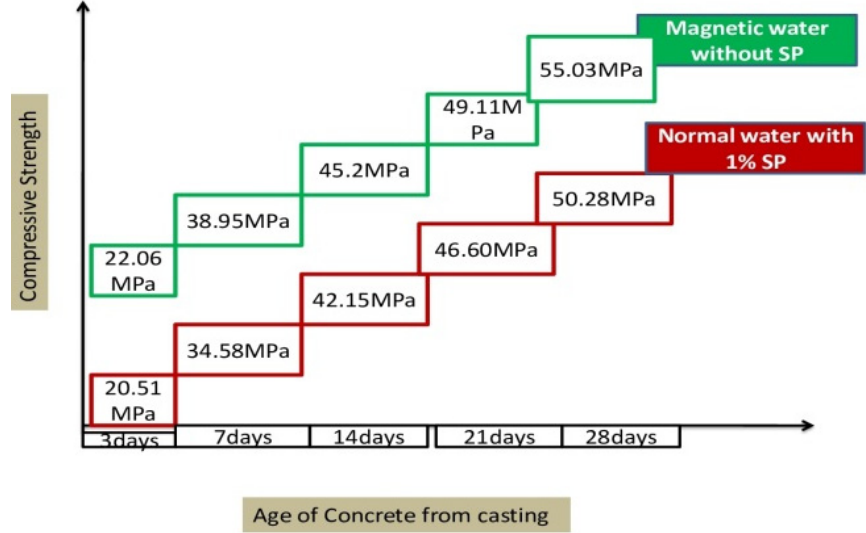
Figure 9. Compressive strength of concrete (NW with 1% optimized SP vs. MW with 0% SP).